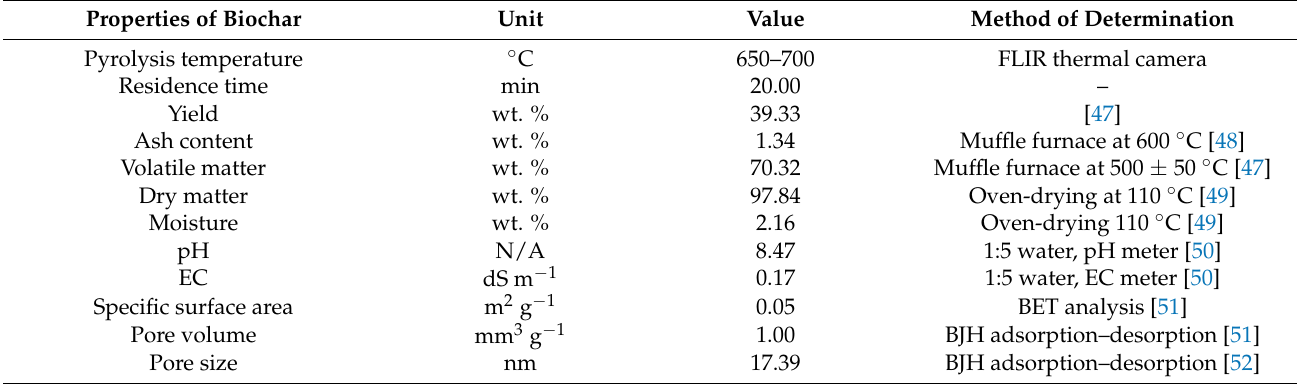
Table 2. Properties of sawdust biochar produced from microwave assist